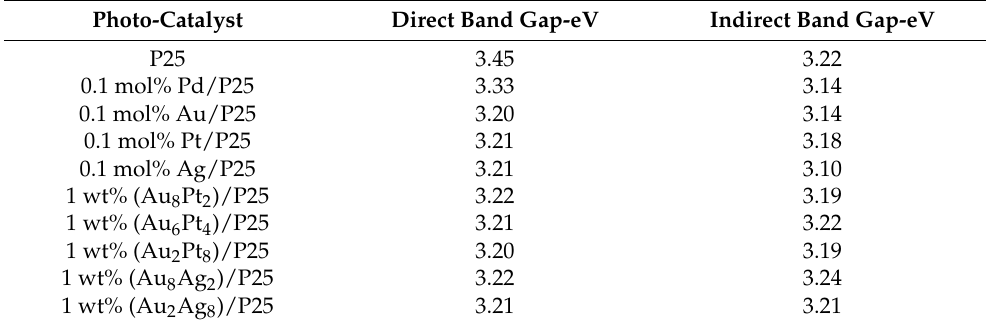
Table 1. Band gap values (direct and indirect) of selected photo-catalyst obtained by reflectance measurements and Kubelka-Munk transformation. Photo-Catalyst Direct Band Gap-eV Indirect Band Gap-eV P25